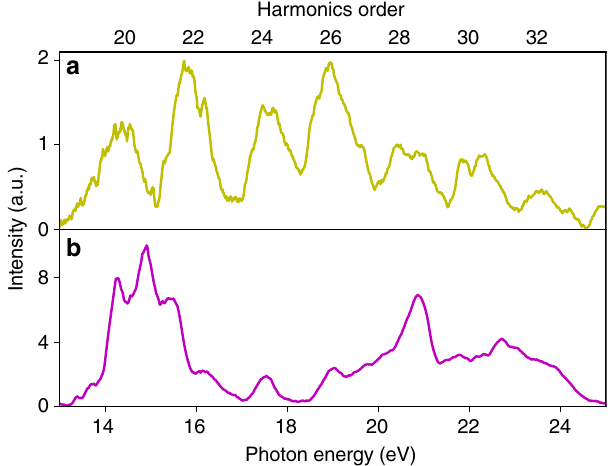
Fig. 1 Measured high-harmonic spectra of fused silica and crystalline quartz. High-order harmonics are produced by focusing intense two-cycle laser pulses onto ~100 μ m thick samples of fused silica and crystalline quartz. The central wavelength of the laser is ~1700 nm (0.73 eV). A portion of the spectrum is measured, which shows that the high-energy end extends to ~25 eV. Both samples withstand repetitive excitation with the maximum peak fi eld of ~2 VÅ − 1 . The resulting harmonics spectra from fused silica and crystalline quartz are shown in a , b , respectively. The spectrum from fused silica consists of discrete harmonic peaks separated the carrier-envelope phase setting. The spectrum from crystalline